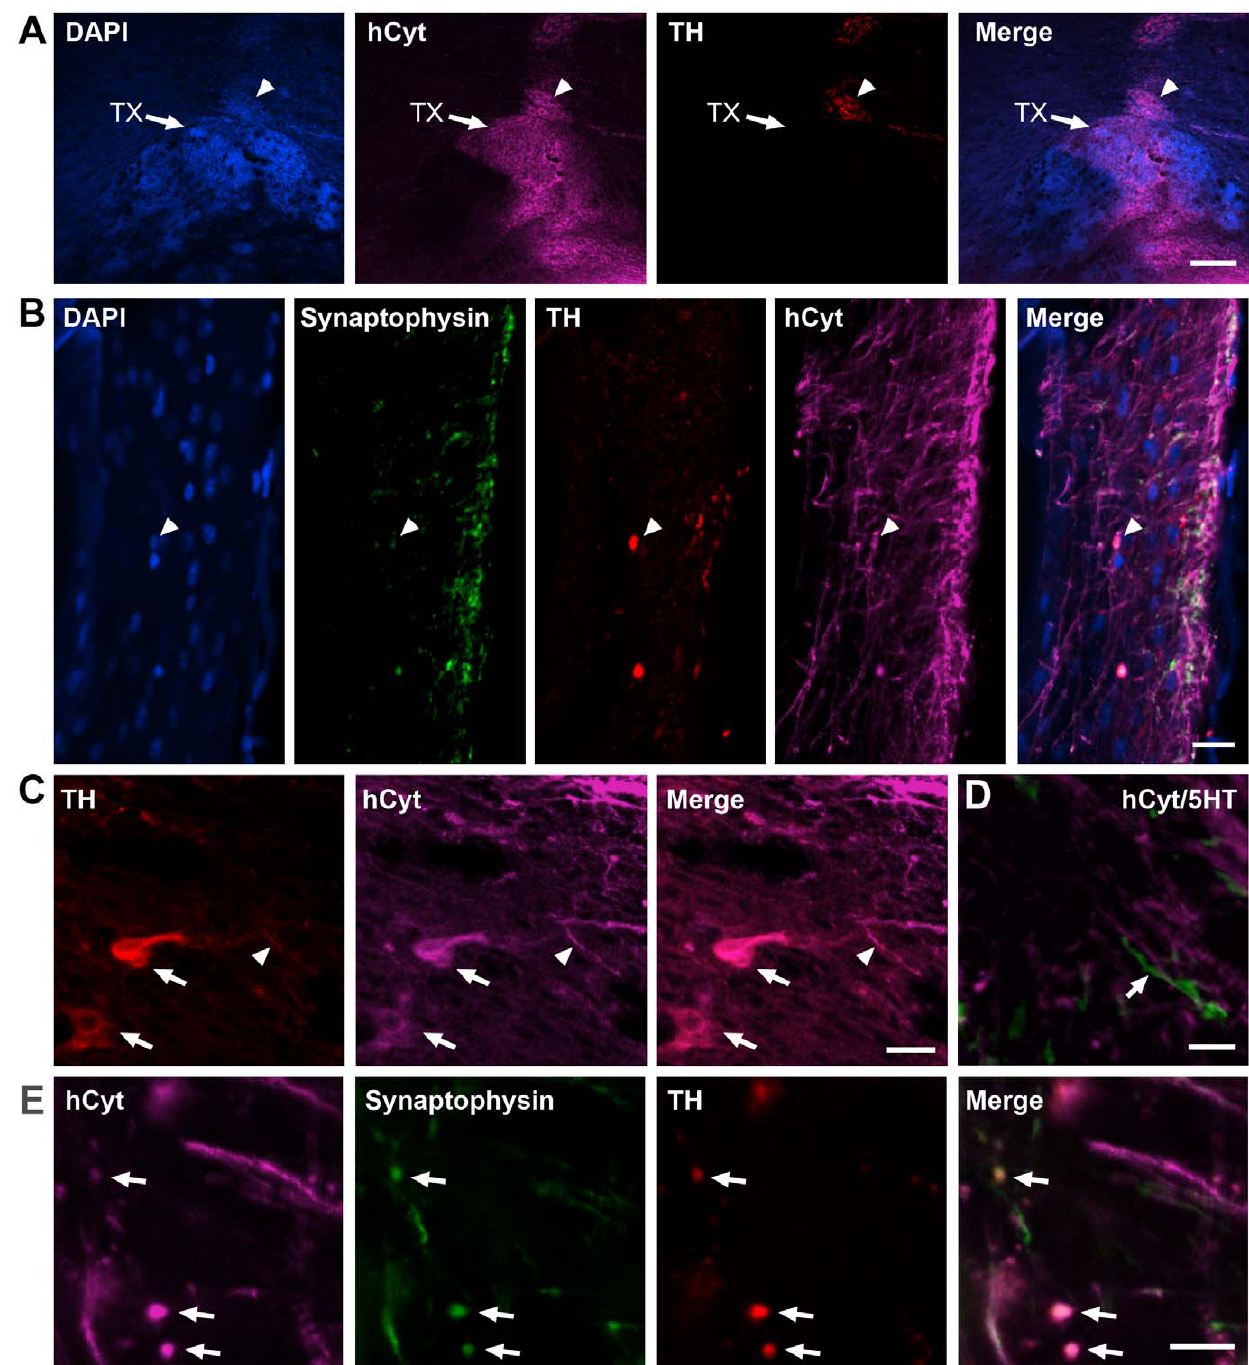
Figure 5. Grafted dopamine-induced hNSCs maintain their phenotype in MPTP-lesioned NHP. Coronal section through the caudate/ putamen of an MPTP-lesioned NHP (A), show transplant (TX) of hNSCs counterstained with the nuclear marker DAPI (blue) and immunoprocessed for the human-specific cytoplasmic (purple, hCyt) and the TH (red). (B) Photomicrograph taken from the edge of the graft showing triple labeling with hCyt (purple), TH (red) and the synaptic marker synaptophysin (green). An example of TH + cell is shown in C, and photomicrograph in D show that the neuritic process extended by the hCyt + grafted cells (purple) do not express the serotoninergic marker (5 HT, green) indicated by the arrow and expressed by endogenous neurons. The TH + neurite outgrowth express synaptophysin + puncta (E). Scale bars are 200 m m (A), 20 m m (B–C), 10 m m (D–E). doi:10.1371/journal.pone.0041120.g005 Two transcription factors, Lmx1a and Msx1, have been Lmx1a and Msx1 were over-expressed in mouse ES cells (mESCs). reported to be critical for the specification of the midbrain DA To induce DA phenotype in mES-derived neural cells, cultures neurons [45]. To test the potential application of these findings, were exposed to bFGF, FGF8 and SHH. In cultures treated with